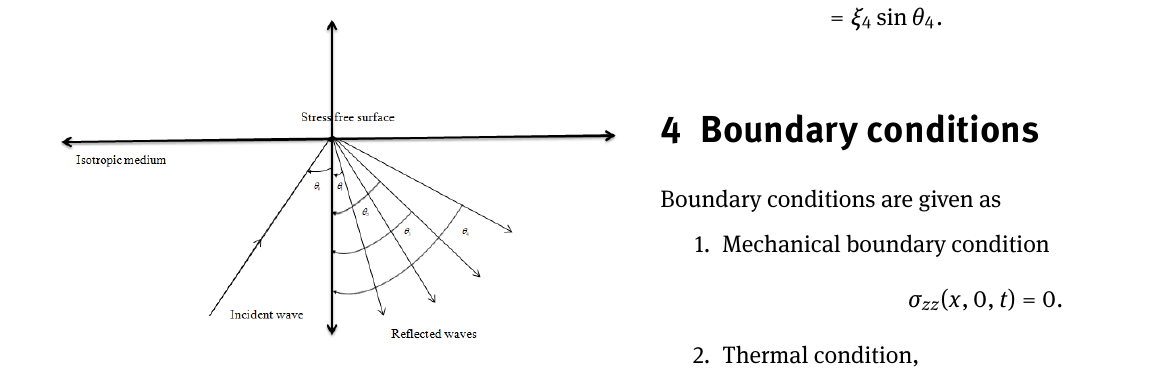
Figure 1: Geometry of the problem